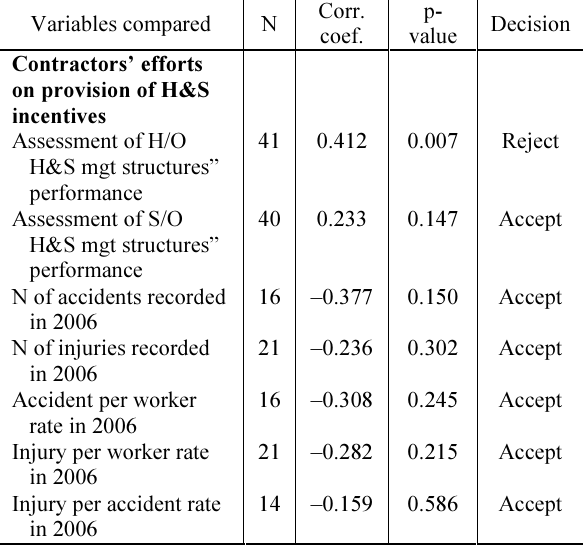
Table 7. Results of Spearman correlation between